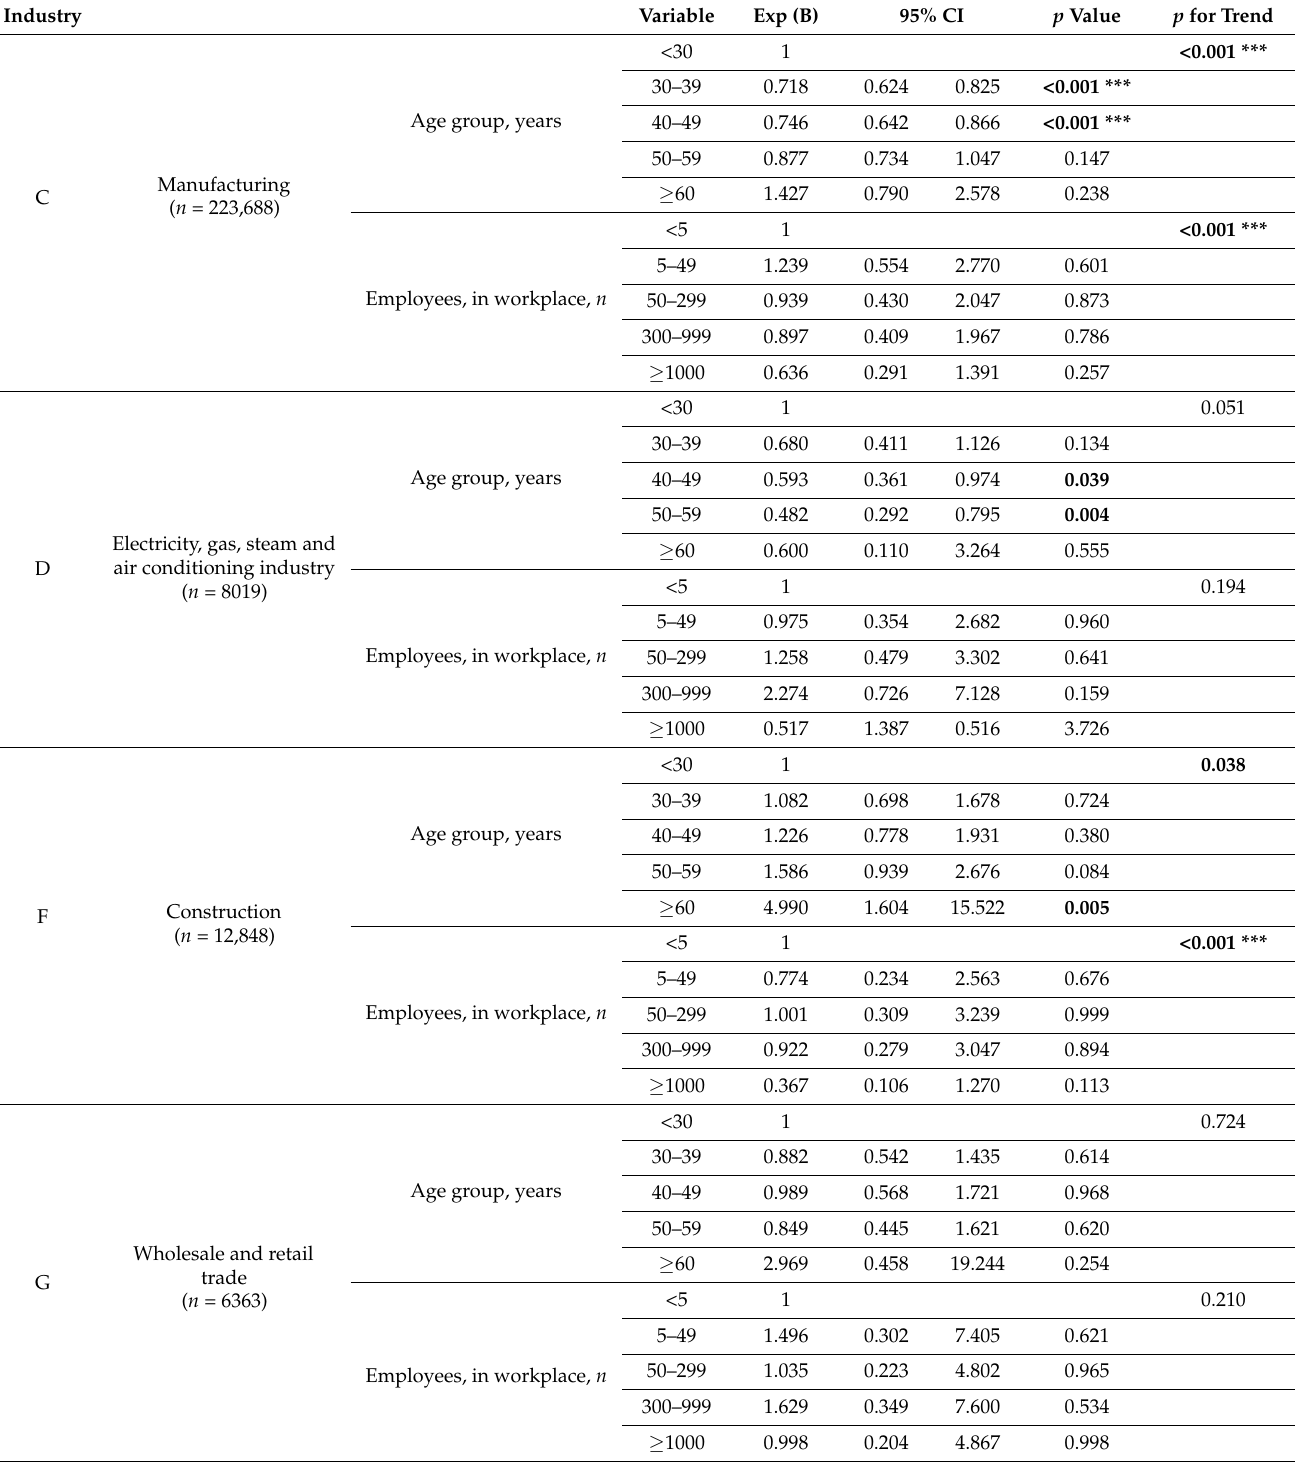
Table 2. Insomnia symptoms of each industry in men from the night-shift Workers’ Specific Health Examination in 2015 *. Industry Variable Exp (B) 95%